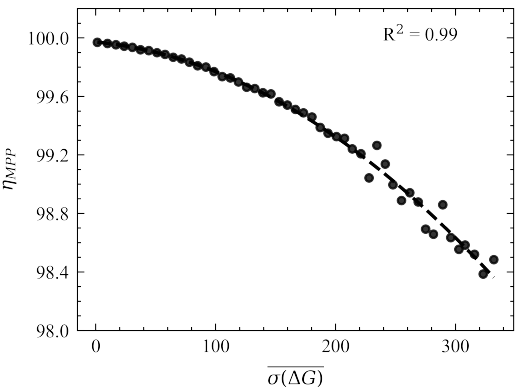
Figure 3. Drop of the binned average efficiency, ¯ η MPP , of the P&O algorithm as a function of the mean irradiance variability in each bin, σ ( ∆ G ) . The coefficient of determination ( R 2 ) is included in the graph to indicate the goodness of fit. Other variability metrics can also be fitted with the model. The fitting parameters are given in Appendix A.